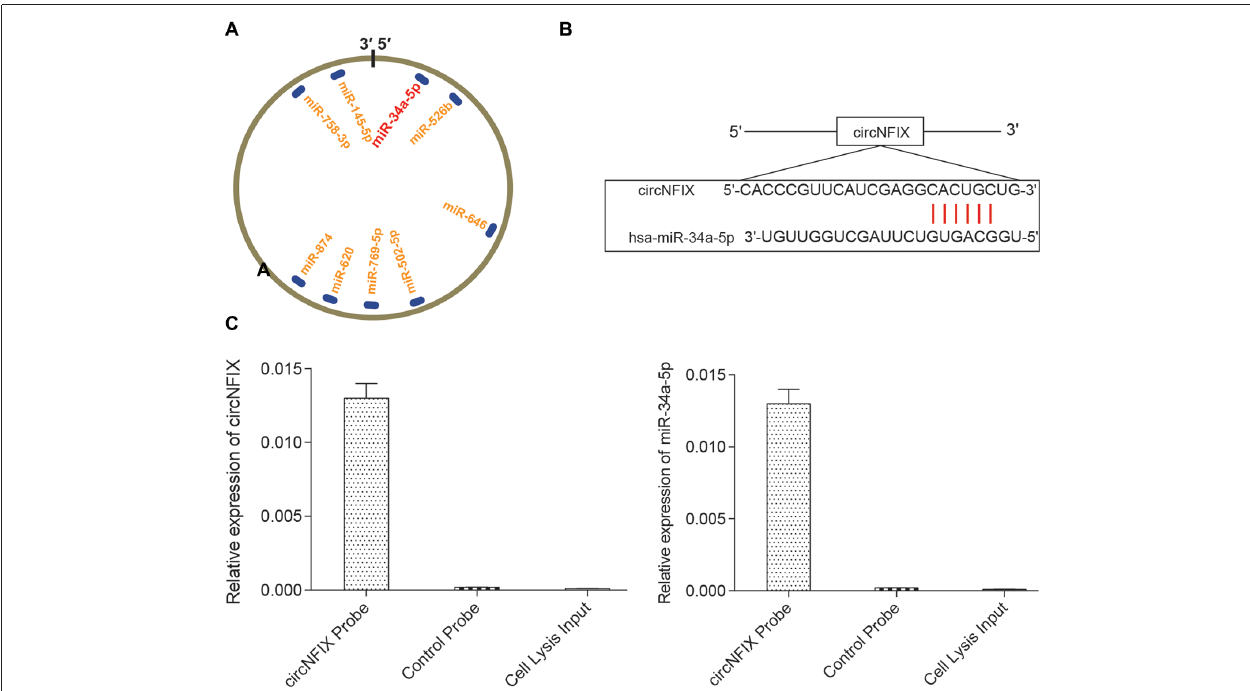
FIGURE 3 | CircNFIX had a predicted binding relationship with miR-34a-5p. (A) There were several binding sites on the circRNA. (B) CircNFIX had a binding site with hsa-miR-34a-5p. (C) The RNA immunoprecipitation (RIP) assay confirmed the targeted relationship between circNFIX and